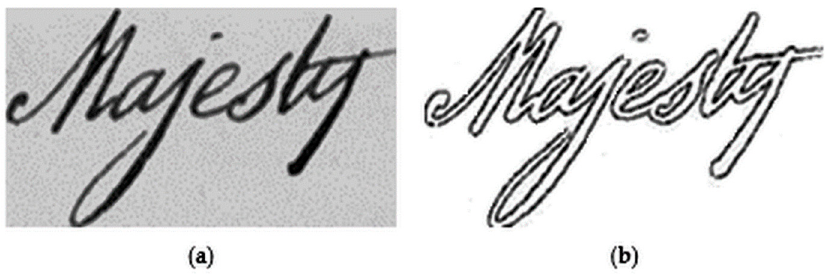
Figure 4. Effect of contrast normalization on an input handwritten word image. ( a , b ) represent input word image and contrast normalized word image respectively.